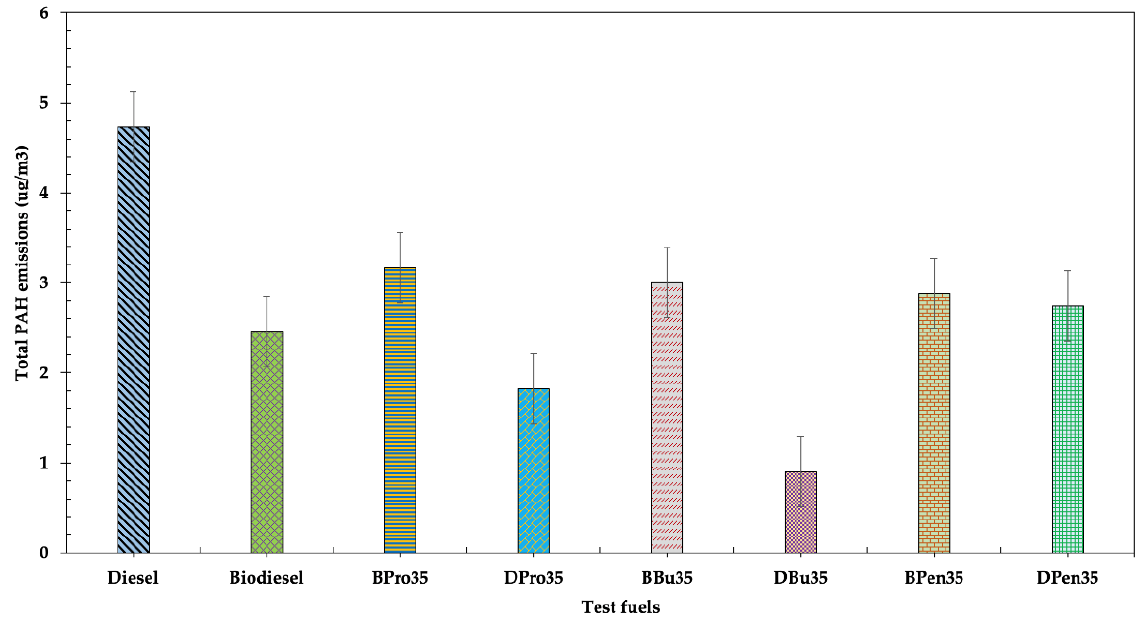
Figure 2. PAH Concentration in the exhaust.